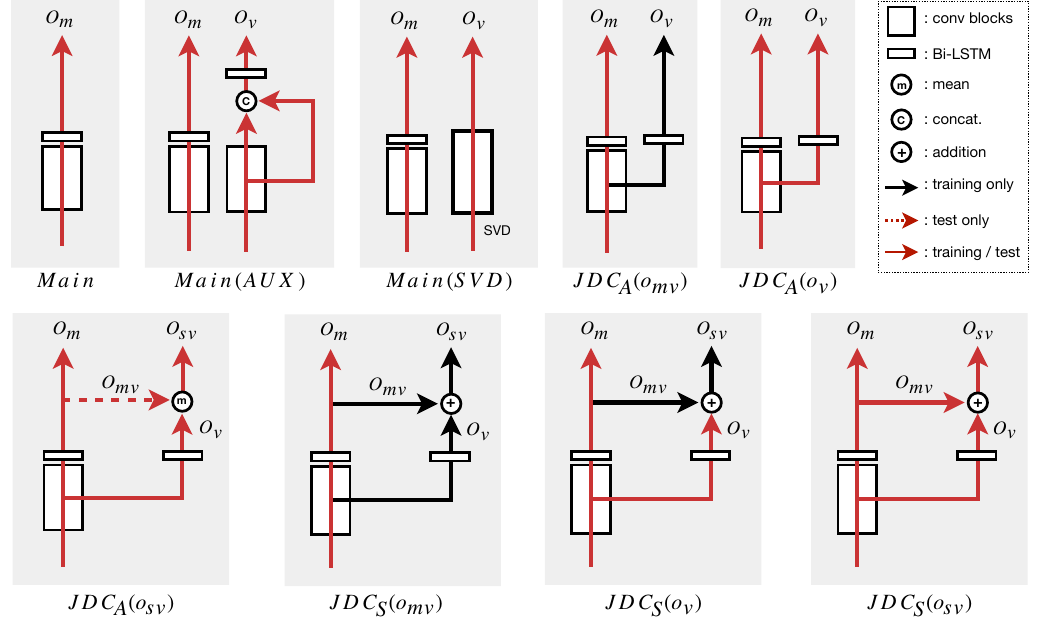
Figure 2. Architectures of melody extraction used for performance comparison in this paper. In the model name, the subscript refers to the type of JDC network, and parentheses refer to the source of voice detection output. The black and red solid arrows indicate the paths used for training and training/testing, respectively. The red dotted arrows indicate the path used for the test, although it was not used for